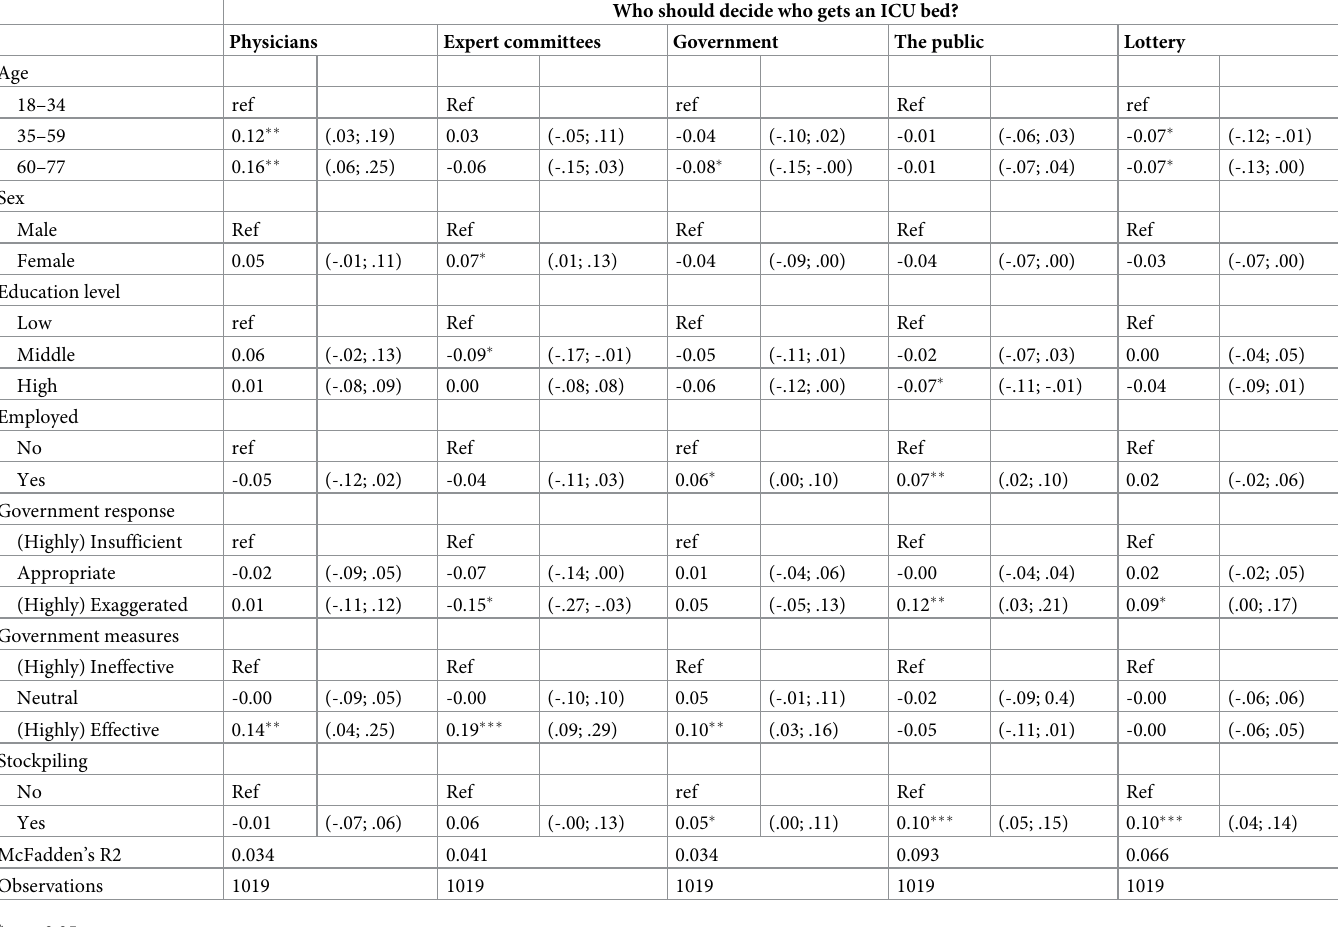
Table 4. Probit regressions preferences for decision-makers; average marginal effect (95% confidence